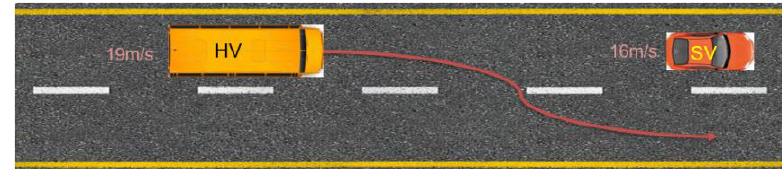
Figure 11. One of the working conditions for collecting driver data.